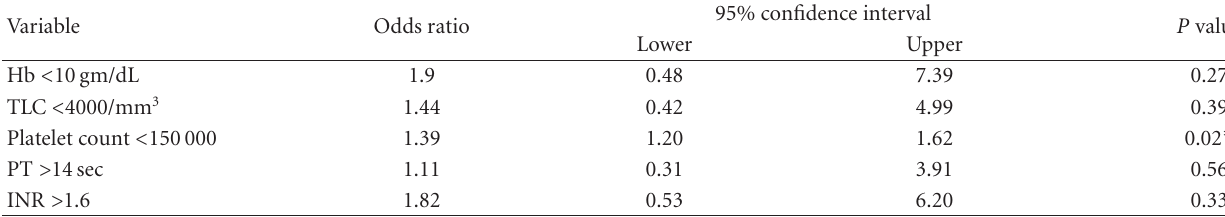
Table 5: Univariate analysis: risk factor for